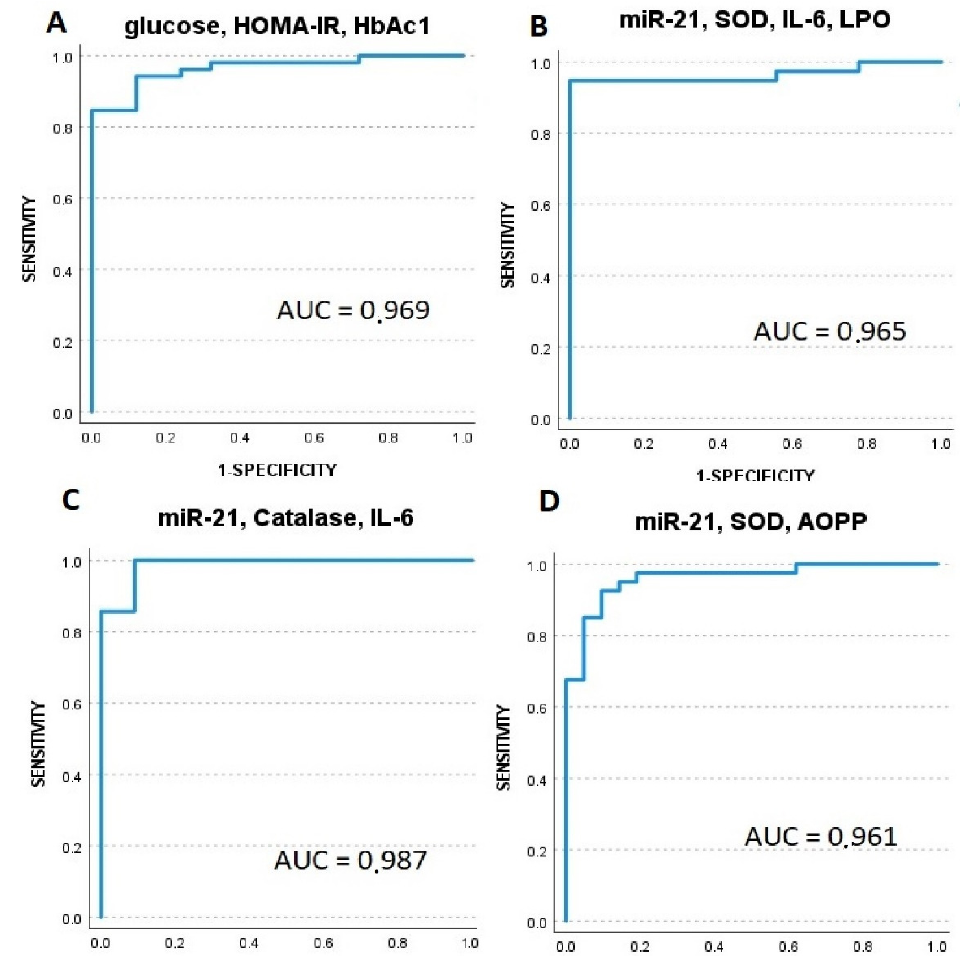
Figure 6. Receiver operator characteristic (ROC) curves generated for sensitivity analysis show diagnostic performances of plasma markers including the following models: ( A )-glucose, HOMA-IR, HbA1c; ( B )-miR-21, SOD, IL-6, LPO; ( C )-miR-21, catalase, IL-6; ( D )-miR-21, SOD, and AOPP. AUC-area under the curve.